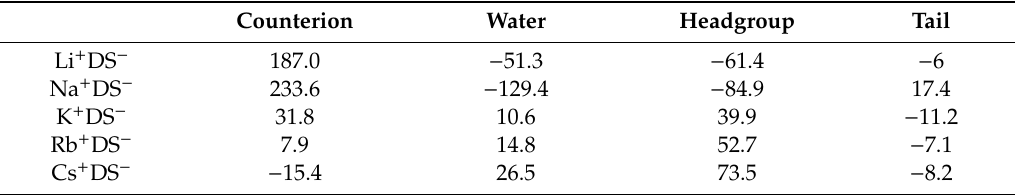
Figure 4. Lateral pressure profile in the systems simulated along the macroscopic surface normal axis, X (black solid curves), as well as the contributions coming from the water molecules (blue dashed curves), alkali counterions (orange dotted curves), as well as from the sulfate headgroups (green dash-dotted curves) and dodecyl tails (red dash-dot-dotted curves) of the DS − ions to these profiles, as obtained in the systems consisting of Li + (top panel), Na + (second panel), K + (third panel), Rb + (fourth panel), and Cs + (bottom panel) counterions. All profiles shown are symmetrized over the two liquid surfaces present in the basic box. Table 2. Contribution of the di ff erent molecules and moieties to the surface tension in the five alkali dodecyl sulfate solutions simulated (in mN / m